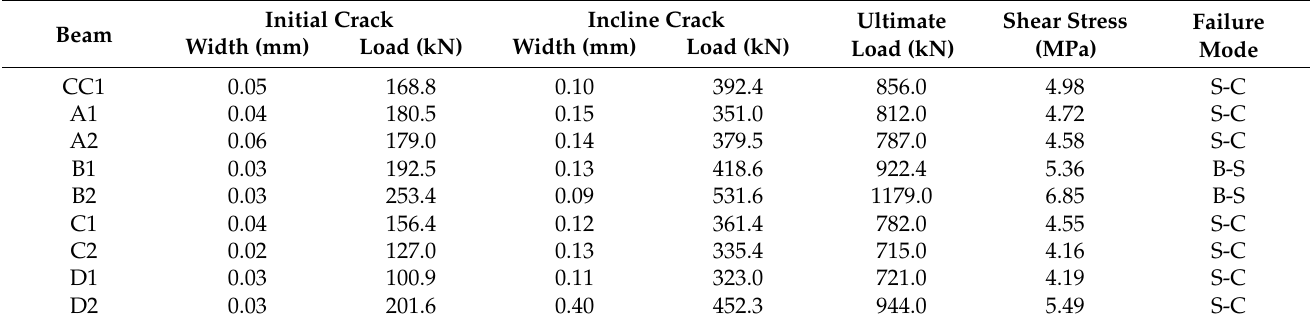
Table 6. Summary of test results for